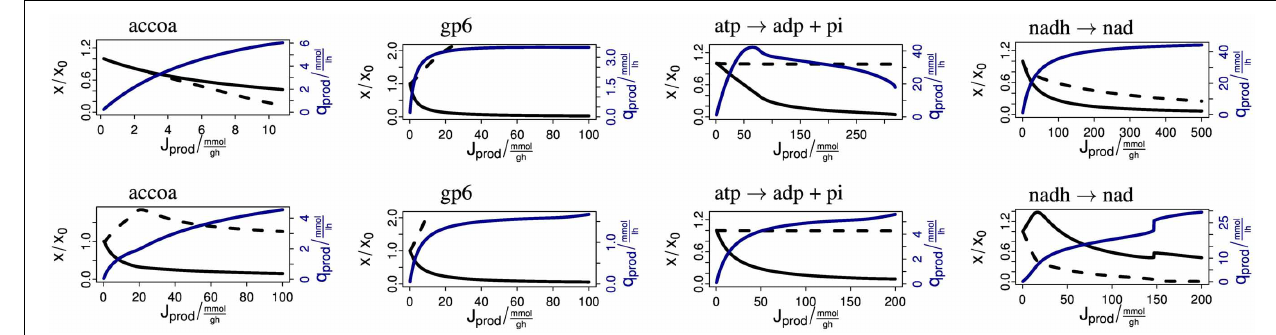
FIGURE 5 | Steady-state response of the model to enforced precursor consumption rates. The upper and lower rows show the results for the aerobic and anaerobic case, respectively. The abscissas shows the biomass-specific production flux in mmol/g/h. The black solid lines show the biomass. The dashed lines show the intracellular